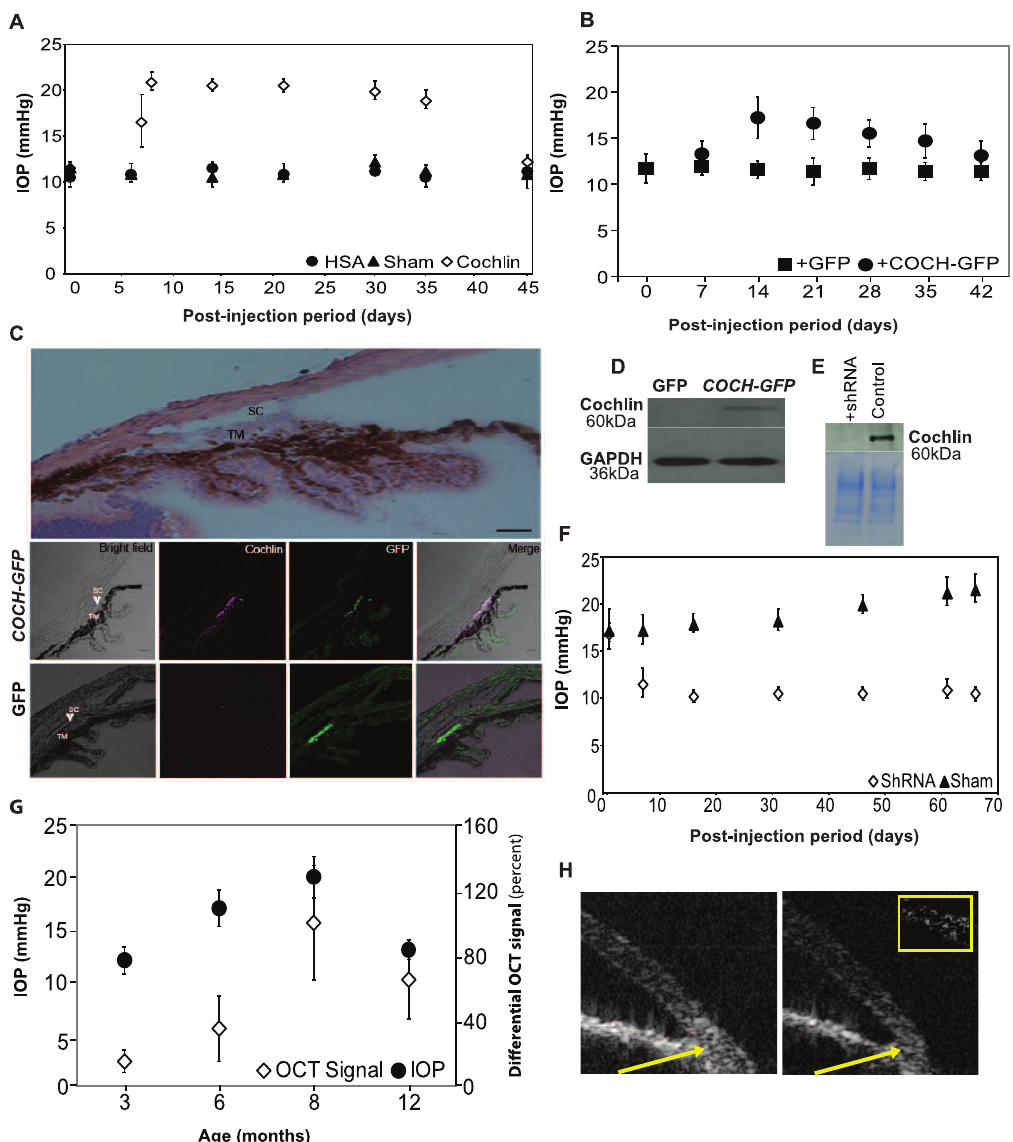
Figure 1. Elevated recombinant cochlin expression in mice TM is concomitant with the IOP elevation. (A) DBA/2J-Gpnmb + /SjJ mice (n=42–48 for each vector at each time point, as indicated by the symbols) at six months of age were injected with a lentiviral vector bearing the COCH-GFP transgene or GFP alone (sham) or human serum albumin (HSA) in the anterior chamber (all under the control of a CMV promoter). IOP was recorded at the indicated time periods. (B) C57BL/6J mice at six months of age were injected with a lentiviral vector bearing the COCH - GFP transgene (n=20) or GFP alone (n=20) in the anterior chamber. The mice were followed and IOP recorded at the indicated time periods. (C) Representative immunohistochemical analysis of DBA/2J-Gpnmb + /SjJ mice eyes injected with COCH-GFP transgene or GFP alone. Top panel shows the anatomy of the anterior chamber stained with haematoxylin and eosin. SC=Schlemm’s canal, TM=trabecular meshwork; Bar=125 m m Bottom panels show eyes injected with COCH-GFP or GFP alone as indicated. The brightfield and antibody probing for cochlin (magenta), GFP (green) and merge image has been shown as indicated. Scale bar=100 m m (D) Western analysis of the TM protein extract of the DBA/2J-Gpnmb + /SjJ mice injected with GFP alone or COCH transgene with IRES mediated GFP expression (COCH-GFP). GAPDH has been shown as a loading control. (E) Western analysis of the TM extracts of DBA/2J mice (8 months old) un-injected control or injected with cochlin shRNA. Coomassie blue stained gel shows total protein loading. (F) Downregulation of cochlin in DBA/2J cochlin + / + mice decreases the mean IOP. DBA/2J cochlin + / + mice (n=38–45 for each vector at each point) at six months of age were injected with a lentiviral vector bearing cochlin shRNA or GFP alone in the anterior chamber. IOP was recorded at the indicated time periods. (G) Level of cochlin expression in the TM of DBA/2J cochlin + / + mice correlates with the IOP. The level of cochlin expression was quantified at different ages (n=10 at each age group) in vivo using the spectral domain OCT (experimental procedures) and IOP are represented by hollow and solid symbols respectively. (H) Representative SD OCT image of the anterior chamber angle a 6 month old DBA/2J cochlin + / + mice before (left) and after (right) injection of infra-red (IR-800) dye coupled anti-cochlin antibody. The arrow indicates the region undergoing a change in intensity of signal before and after injection. The images obtained before and after injection were digitally subtracted for the region of interest (inset). Error bars (A, B, F and G) depict 6 standard deviation.